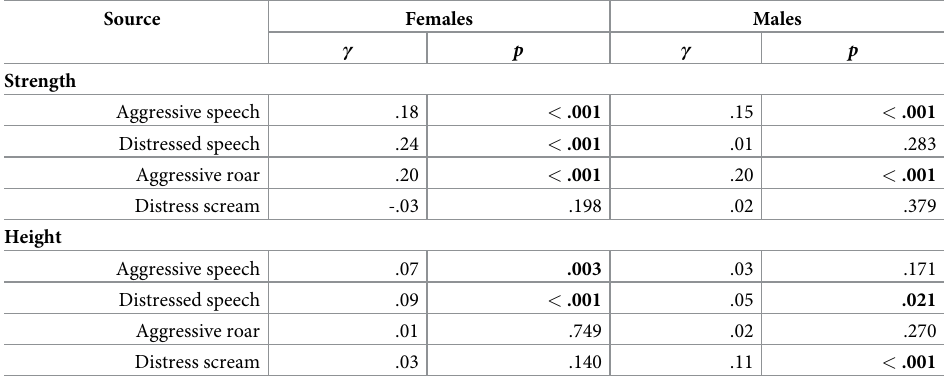
Table 7. Standardised linear mixed model coefficients representing the sensitivity of listeners to variation in vocalizer strength and height. Each coefficient represents the average of listeners’ individual slopes for the relation- ship between actual strength/height and attributed strength/height. Significances represent whether each average slope was significantly different from zero. Separate models are reported for male and female vocalizers.